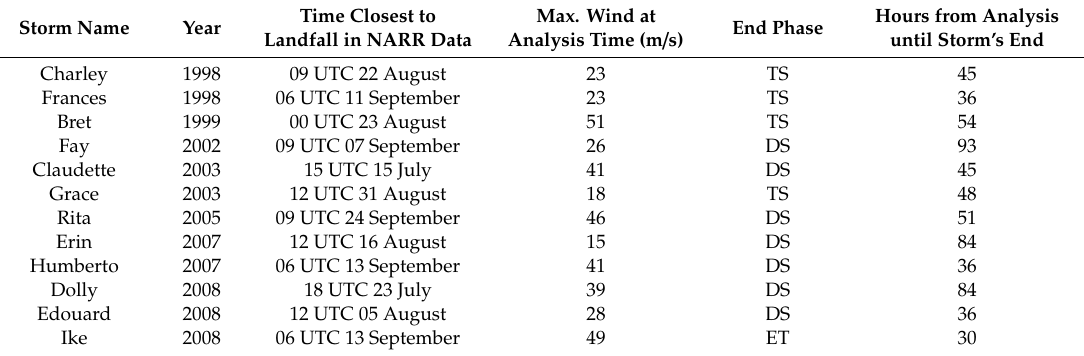
Table 1. Western group tropical cyclones (TCs) and their time of rainfall analysis, maximum sustained wind speed at that time, the phase of the storm at its last observation in the database, and the time from rainfall analysis until the last observation in the database. For end phase, TS: tropical system, DS: disturbance, ET: extra